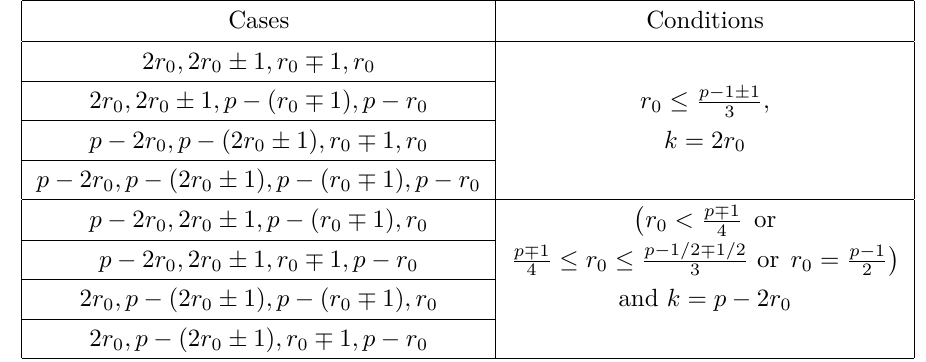
Table 13. The other set of possible CBs in minimal models that Γ 0 (4) ∩ Γ(2) corresponds to. There are similar relations for s 0 by a simple substitution of the corresponding letters, where 0 , l, p we have set α = α 4 r 0 ,s 0